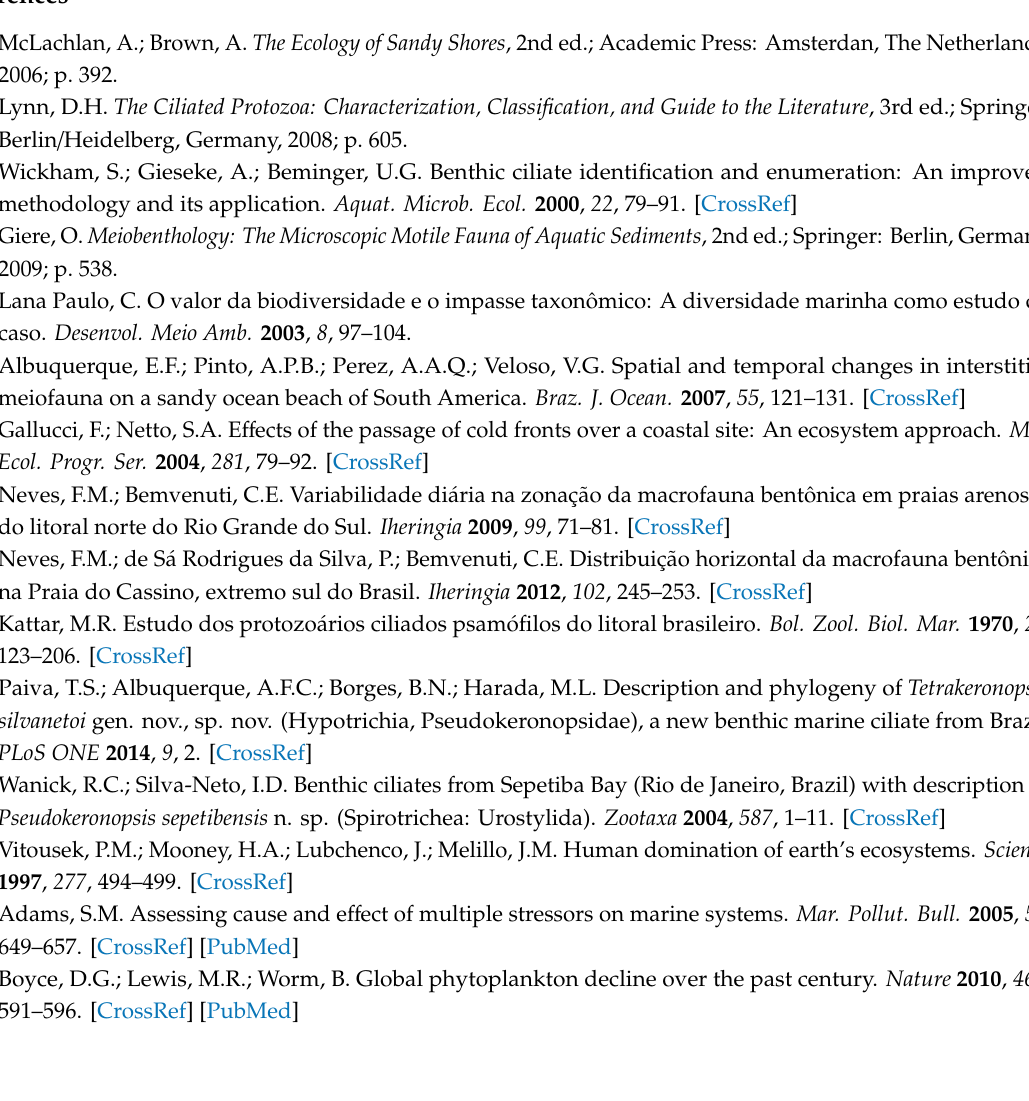
Table S1: List of ciliate species found in the coast of Rio Grande do Sul state (Brazil) between June 2016 and July 2017. Information on site of collection, season, and mean abundance of the species in the given season are provided. For abundance estimates di ff erent species in the same genus were counted under the genus